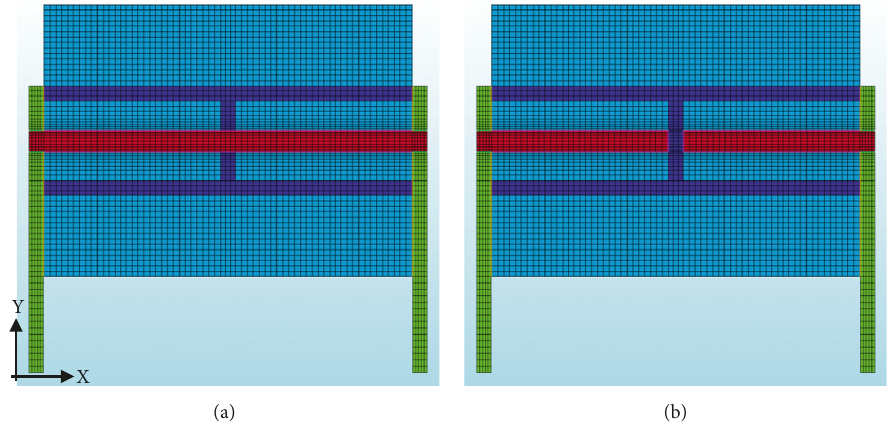
Figure 8: 2D models of the experimental specimen: (a) 1-bar and (b) 2-bar.